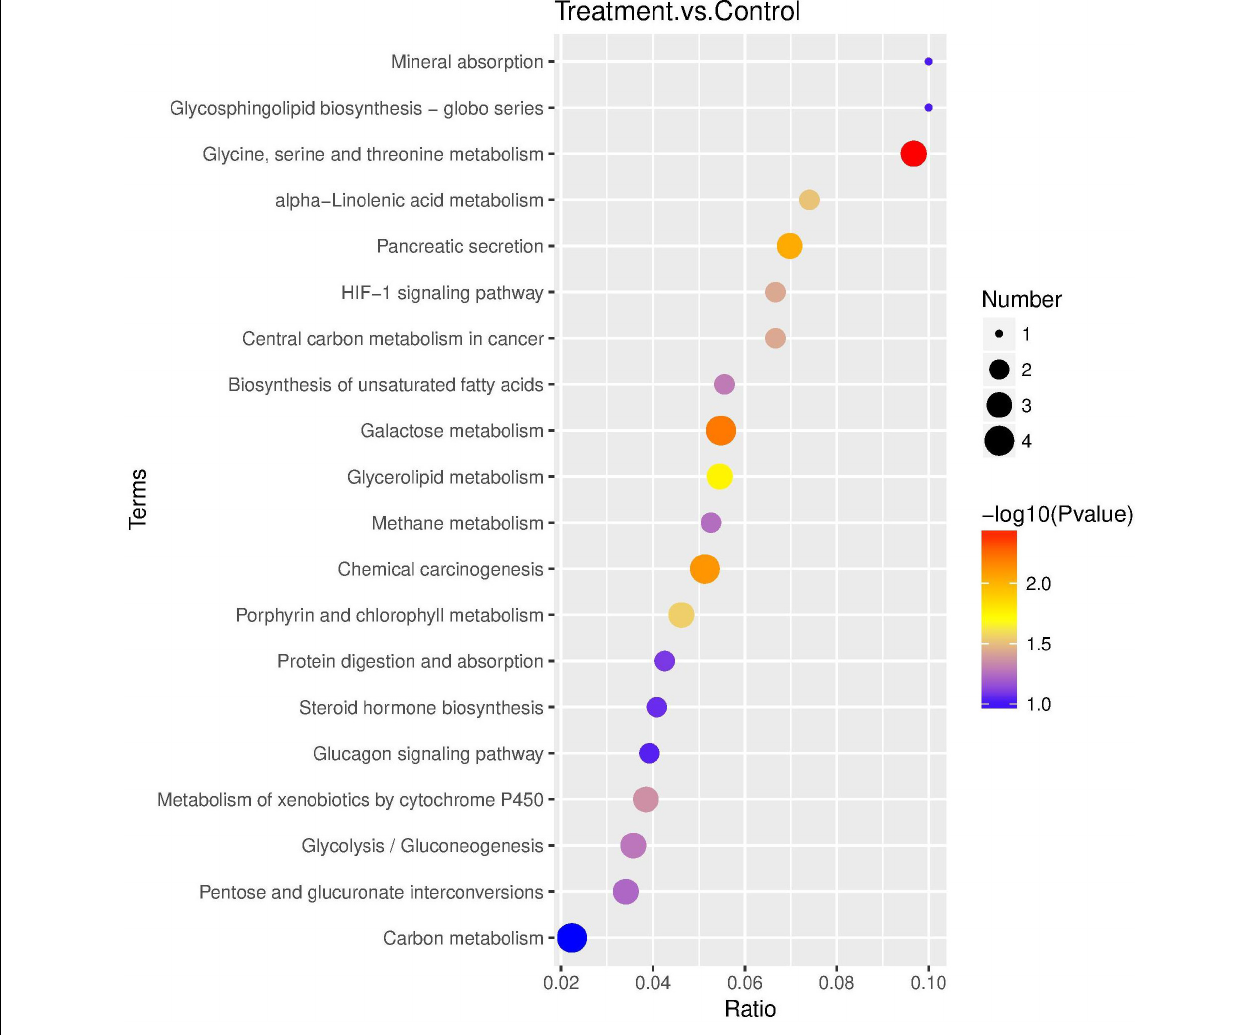
FIGURE 5 | KEGG pathway enrichment bubble plot. The ratio of the number of different proteins in the corresponding pathways to the total number of proteins identified in the graph is greater, indicating the higher difference in protein concentration in the pathway. The size of the dots represents the number of different proteins in the corresponding pathway and the greater the difference in the pathway represents the greater number of